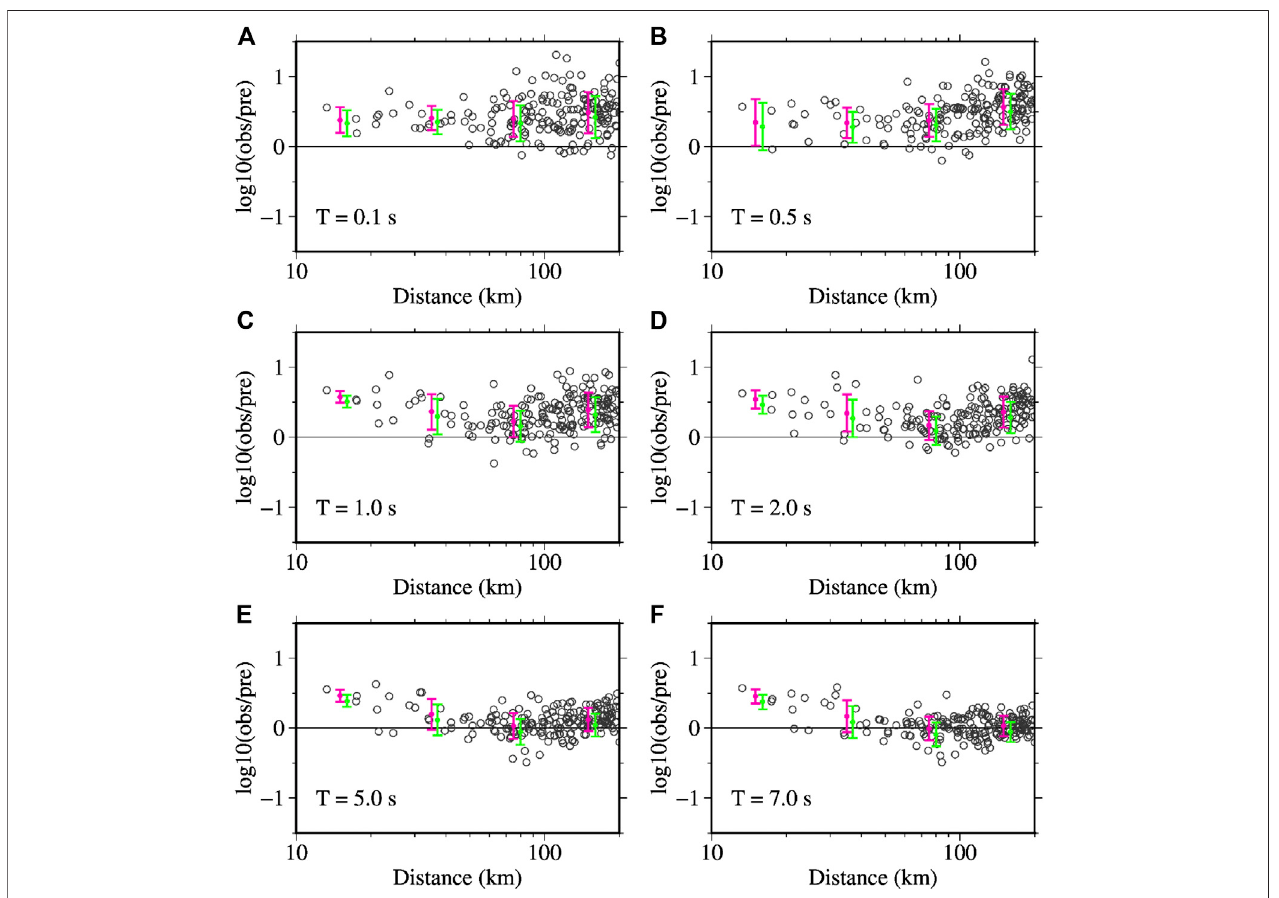
FIGURE12| Plotsofresidualsasafunctionofhypocentraldistanceafterthesitecorrectionsfortheaccelerationresponsespectra(ARS) attheperiodsof0.1,0.5, 1,2, 5,and7sinpanels, A-F ,respectively, usingtheprediction equationsinMorikawaand Fujiwara (2013).Theresidualvaluesshownintheplotswereobtainedforthe Mw value of 5.5. The magenta-colored vertical bars denote the error bars for binned data with mean error and plus-minus one standard deviation. The green-colored verticalbarsshowtheerrorbarsforcomparisonfortheMwvalueof5.6.Seethesupplementary fi lefortheplotsofARSvaluesasafunctionofhypocentraldistance.